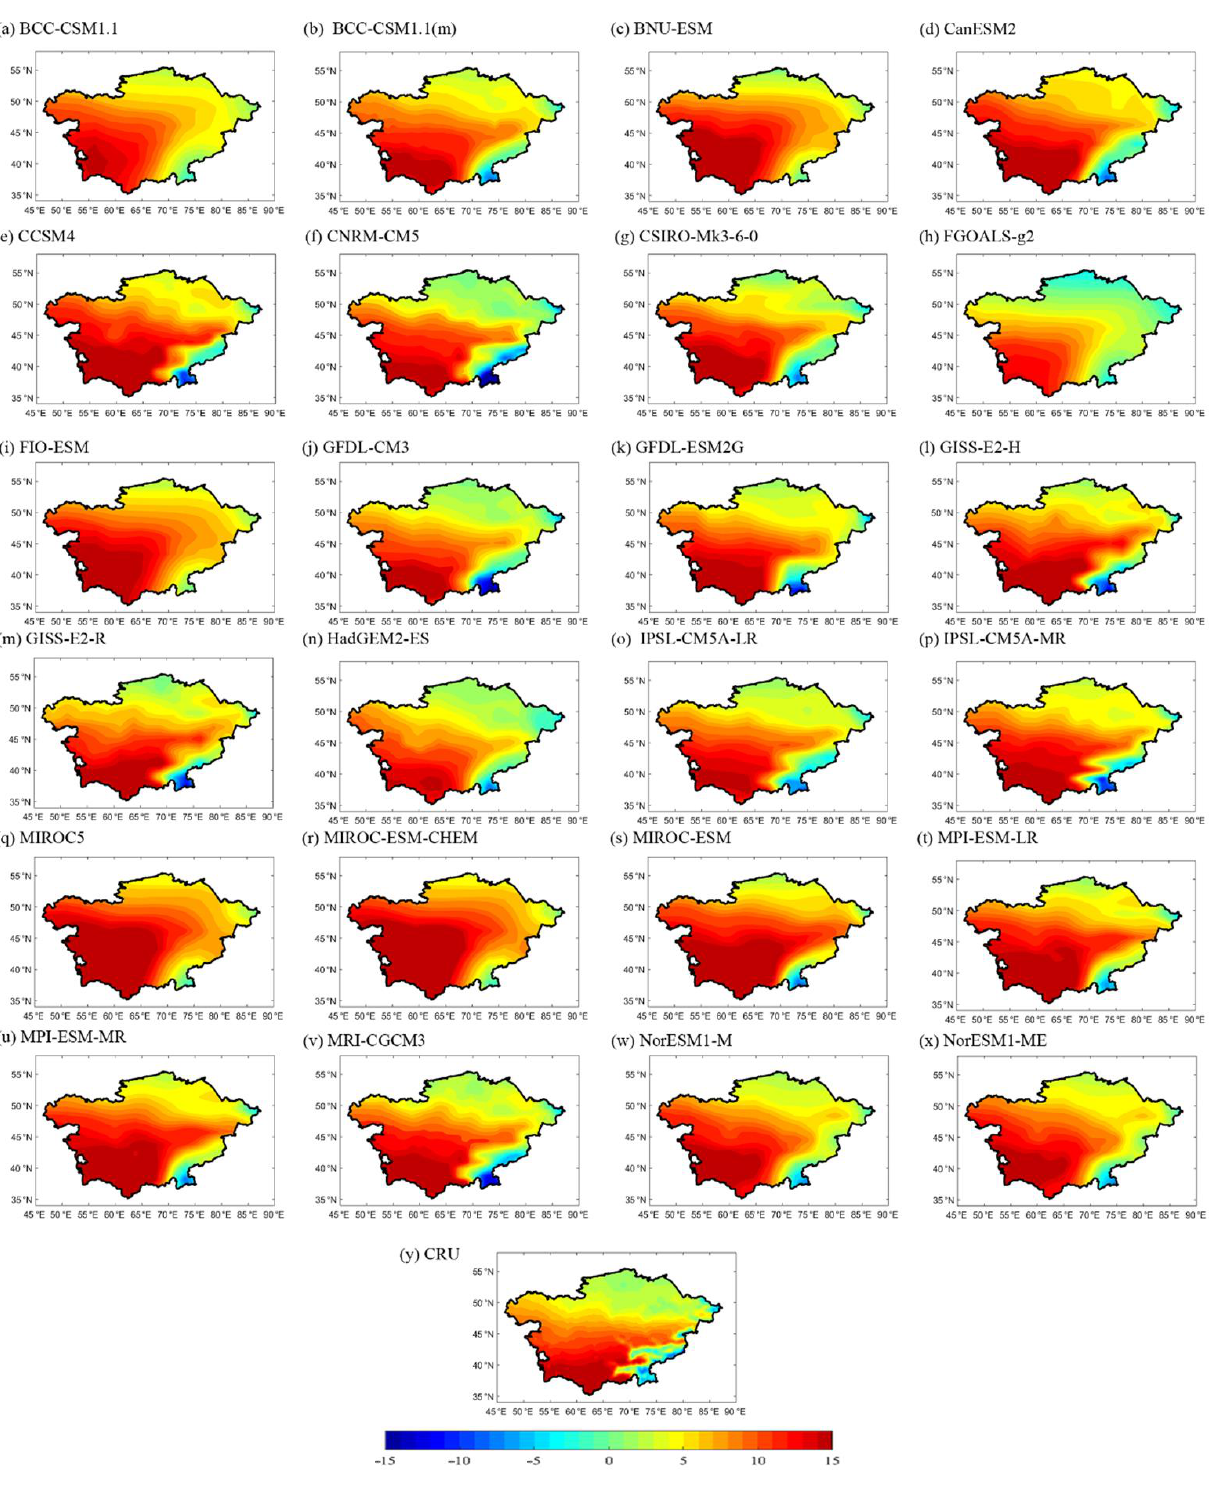
Figure 2. Spatial distributions of the annual mean surface air temperature (SAT), 1901-2005, where ( a – x ) represent the 24 studied CMIP5 climate models as detailed in Table 1 and ( y ) represents the observational data by the Climate Research Unit (CRU).